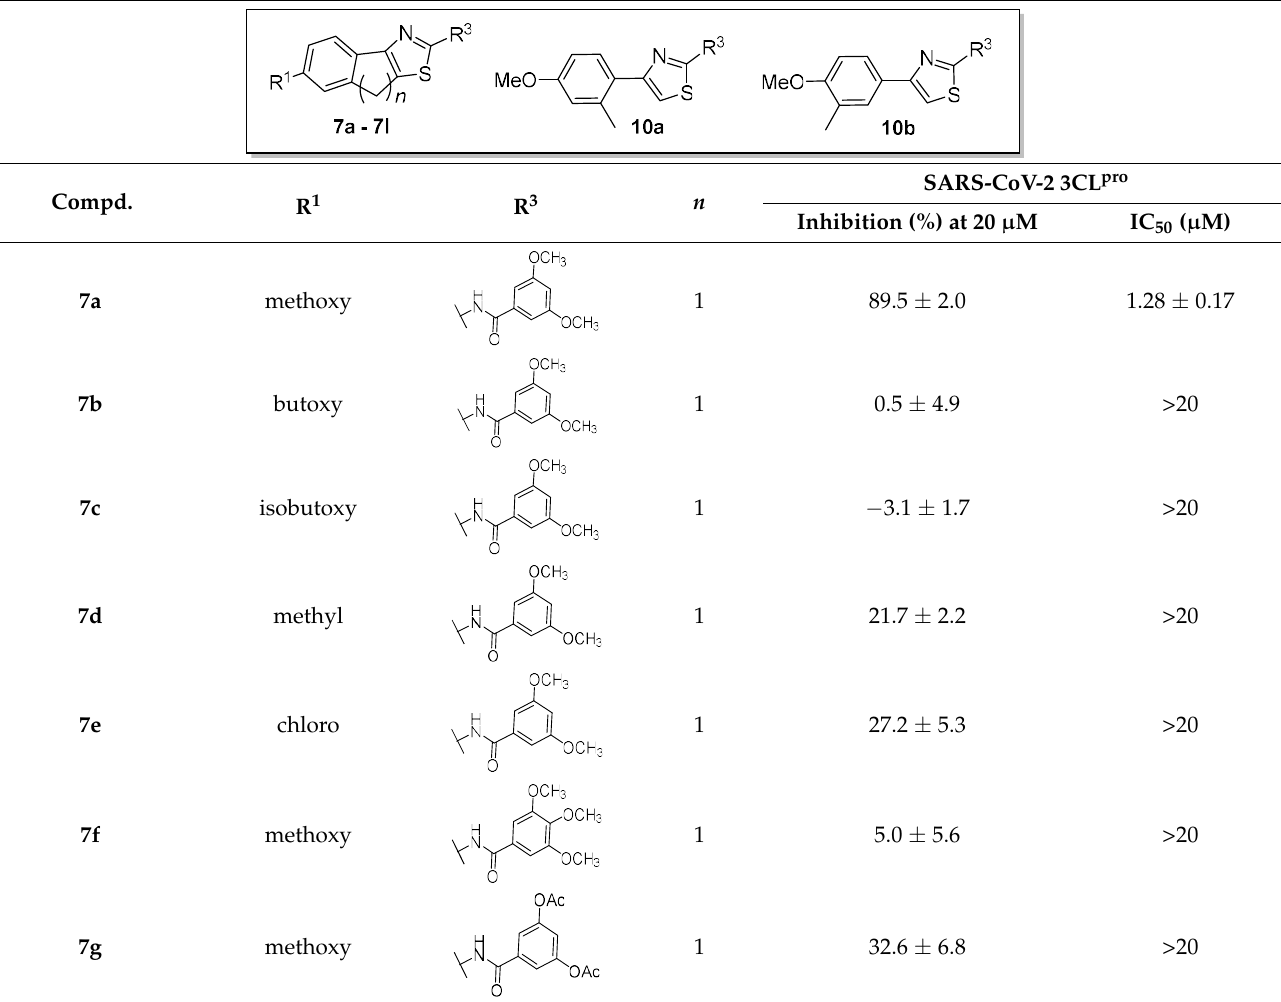
Table 1. Inhibitory activities of target compounds against SARS-CoV-2 3CL pro .